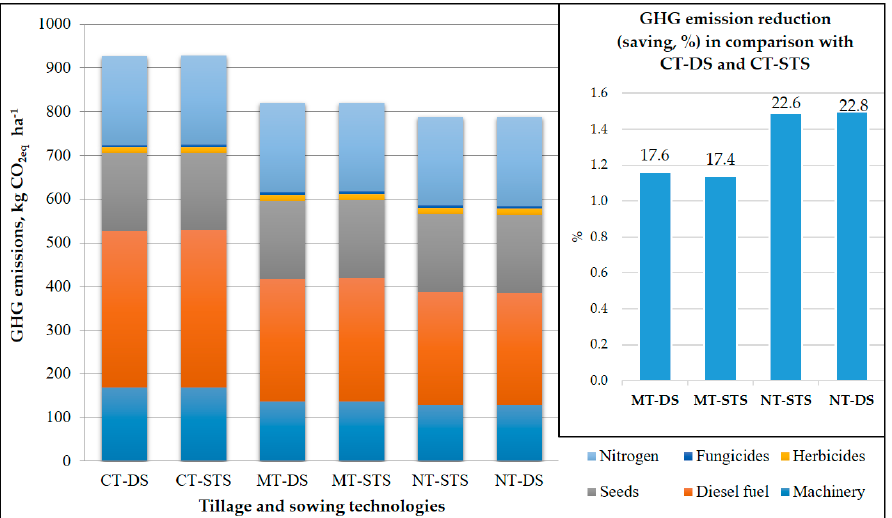
Figure 6. Contribution of different inputs in CO 2eq for winter wheat production .